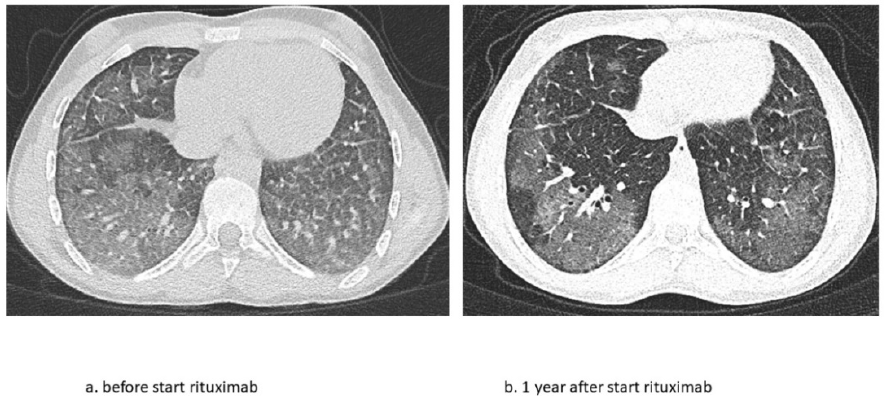
Figure 4. Chest CT scan images before and 1 year after start of RTX treatment during clinically stable disease phase. ( a ) Ground glass opacification as main abnormality and ( b ) fewer ground glass opacifications after 1 year of RTX.